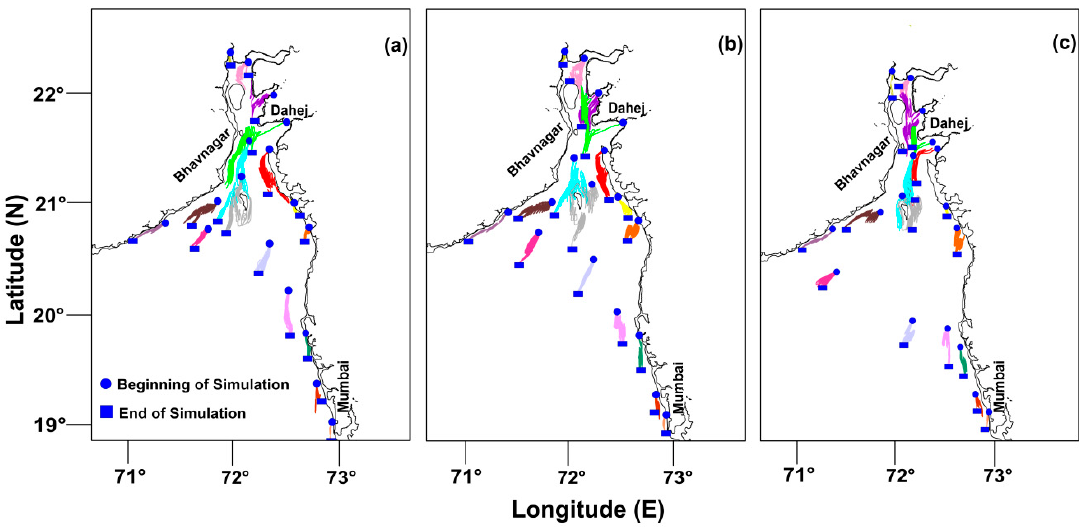
Figure 12. Lagrangian particle track results simulated for a one-month period during different seasons: ( a ) NE-monsoon, ( b ) pre-monsoon and ( c ) SW-monsoon. A total of 27 particle tracks in each season are represented. Particles released inside the Gulf have tendency to circulate there itself in different season.